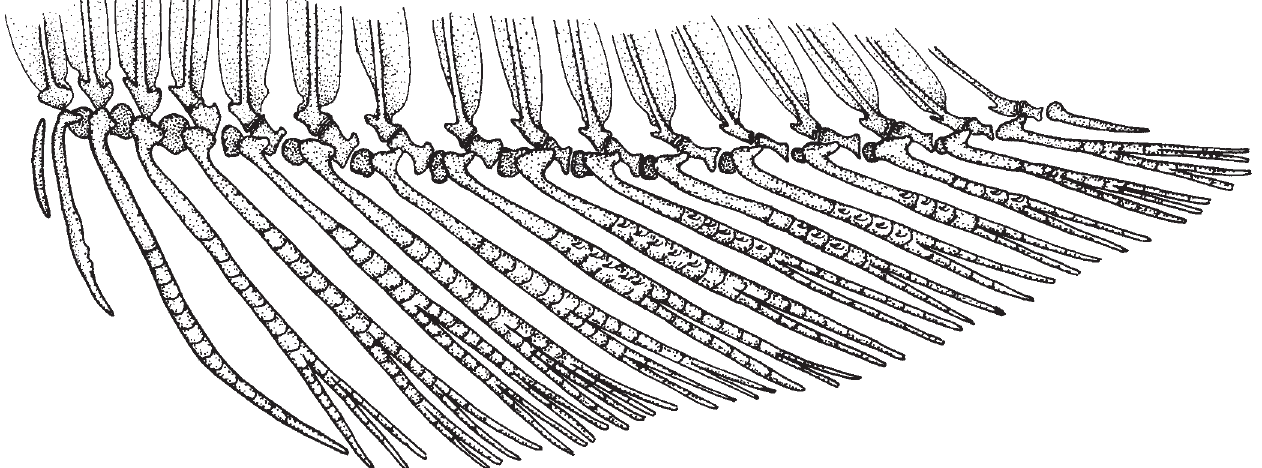
Fig. 6. Attonitus irisae , Vari & Ortega USNM 349698, SL 45.5 mm, adult male. Lateral view of left side of entire anal fin showing fusion of pterygiophores and respective medial radials of anterior two branched rays. Note that the pterygiophores bear anterior and posterior median blades for the origin of the large erectors and depressors anales muscles. Peru: Huanuco; Pachitea, río Huambo at mouth into río